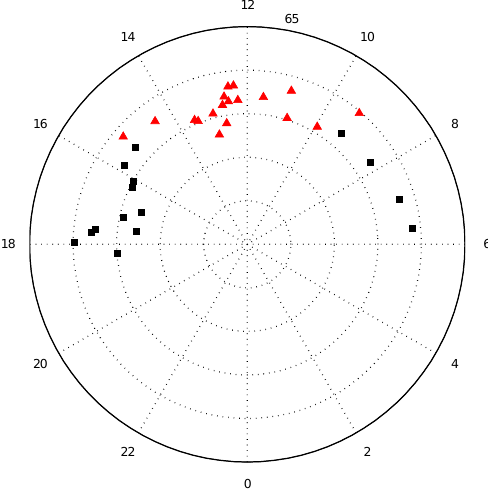
Fig. 9. MLT-invariant latitude ( 3) plot of the locations of all of the open-closed boundary crossings observed by the DMSP satellites between 03:00 and 13:00 UT on 23 November 1999. 12:00 MLT is at the top of the plot and concentric circles are for 3 of 65(5)85 ◦ . The red triangles are for active reconnection footprints (identified by sheath electron and ion precipitations with ion energies near the boundary exceeding 1keV). Black squares are for non-reconnecting (adiaroic) open-closed boundary